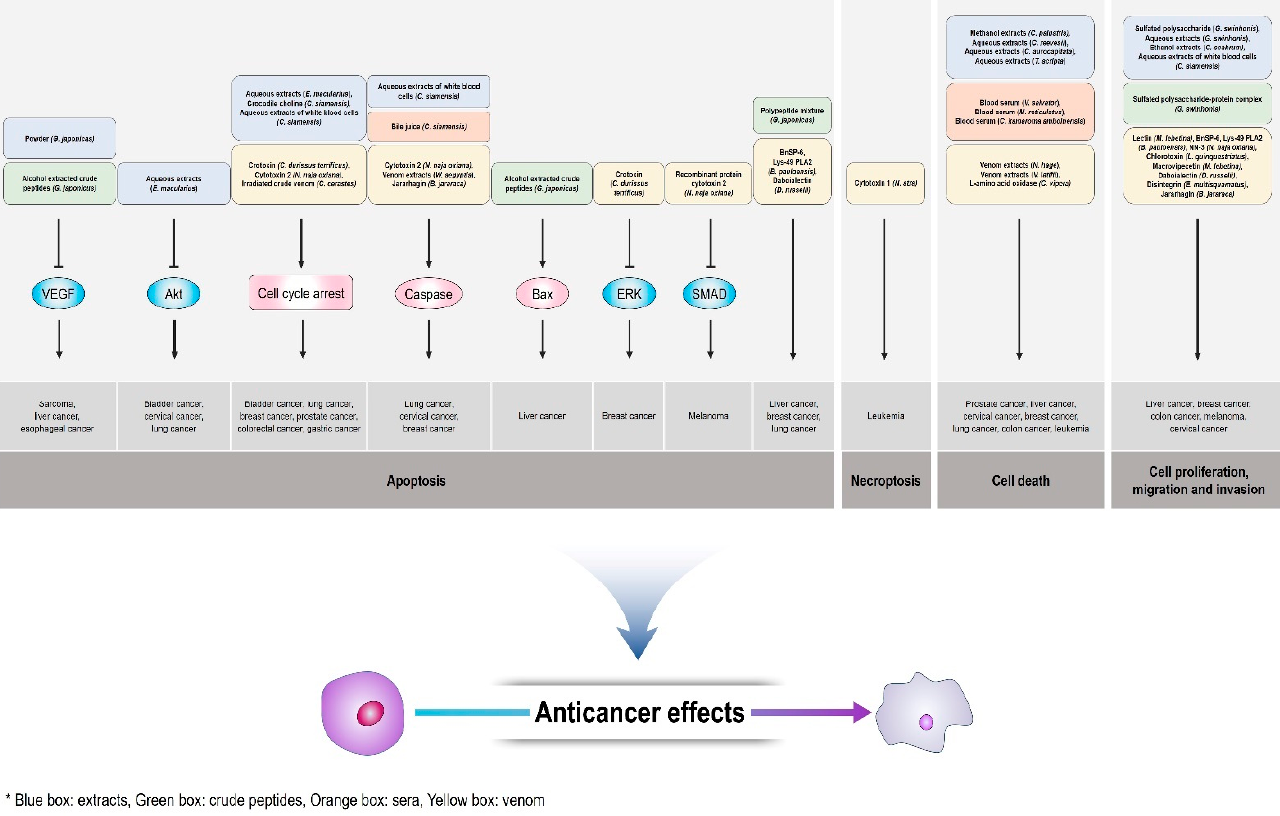
Figure 1. Schematic image of anticancer effect mechanisms of reptile-derived components.